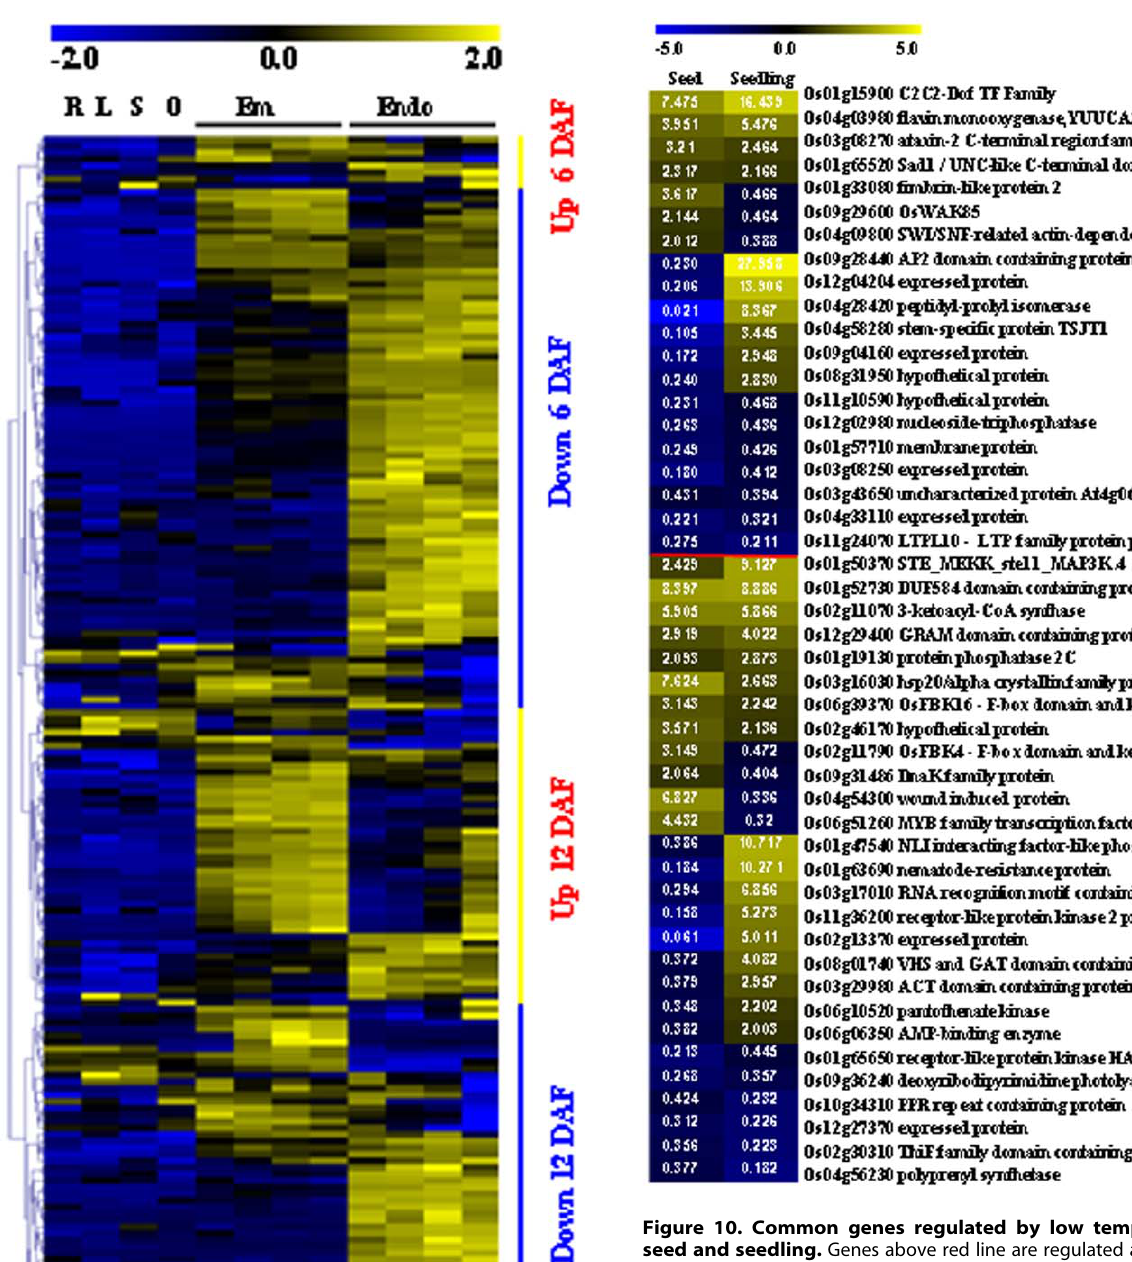
only at certain developmental stages.